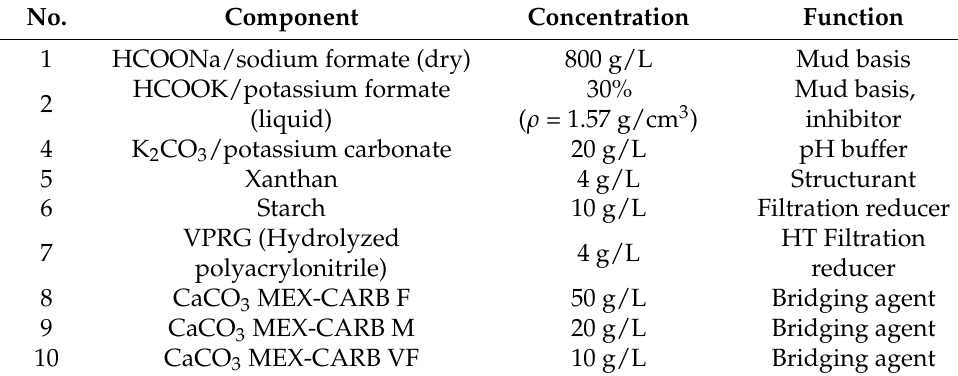
Table 2. Component composition of formate-based solution.